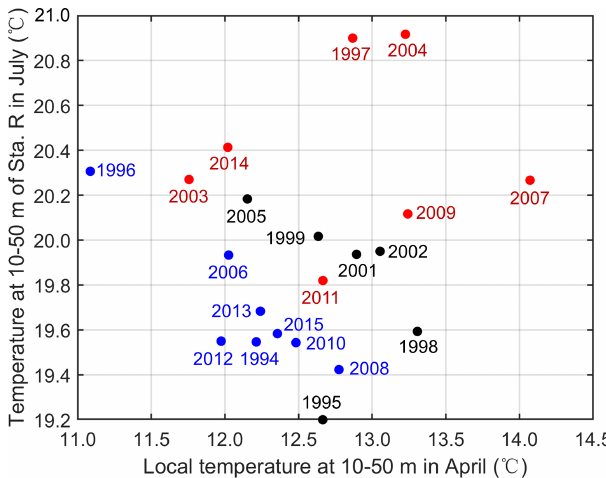
Figure 7. Scatter plot for the Iyo-Nada bottom cold water mass (IN- CWM) intensity (color) according to local water temperature below 10m in April ( x axis) and water temperature below 10m at station R in July ( y axis). Blue, black, and red solid circles represent strong, normal, and weak INCWM years, respectively, which is consistent with the results found in Fig.